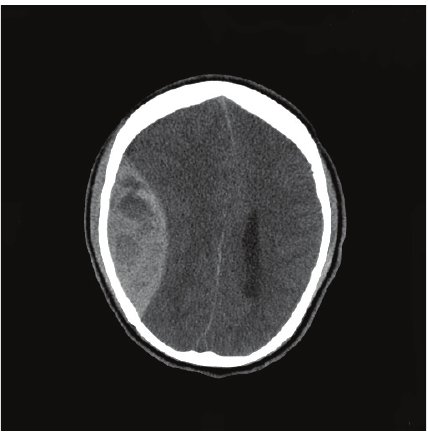
Figure 1: Preop CT showing right large epidural hematoma with midline shift.